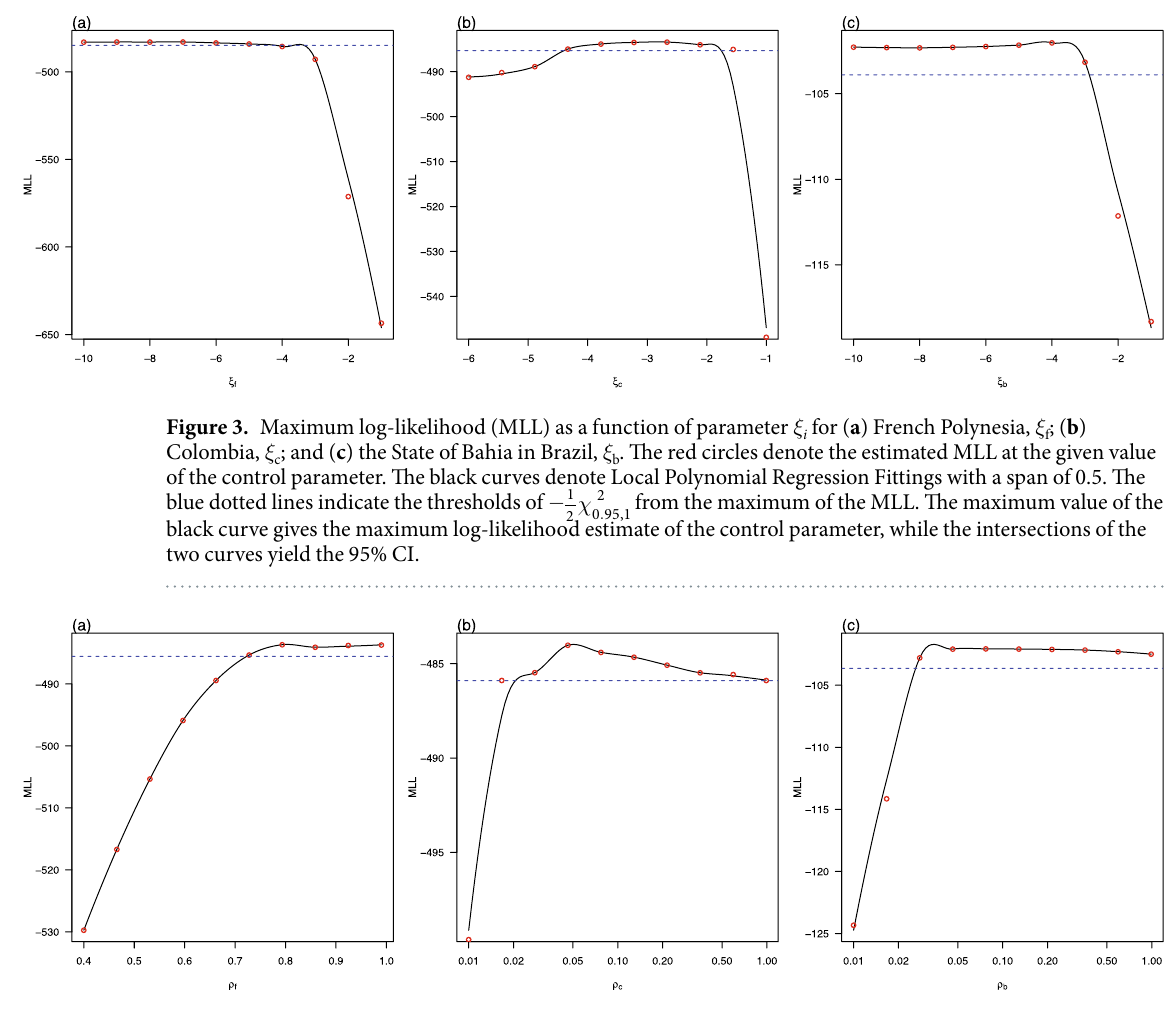
Figure 4. Maximum log-likelihood (MLL) as a function of reporting ratio ρ for ( a ) French Polynesia, ρ f ; ( b ) Colombia, ρ c ; and ( c ) the State of Bahia in Brazil, ρ b , respectively. The red circles denote the estimated MLL at the given value of the control parameter. The black curves denote Local Polynomial Regression Fittings with a span of 0.5. The blue dotted lines indicate the thresholds of − χ maximum value of the black curve gives the maximum log-likelihood estimate of the control parameter, while the intersections of the two curves yield the 95%